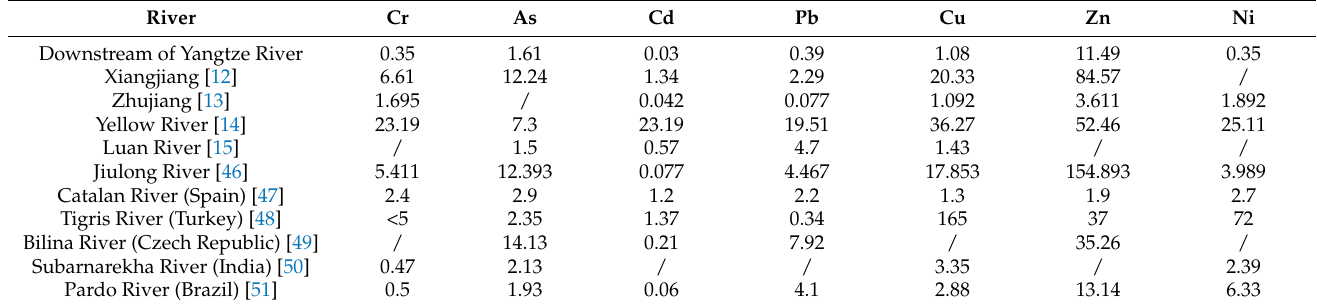
Table 4. Heavy metal concentrations in different waters in China and other